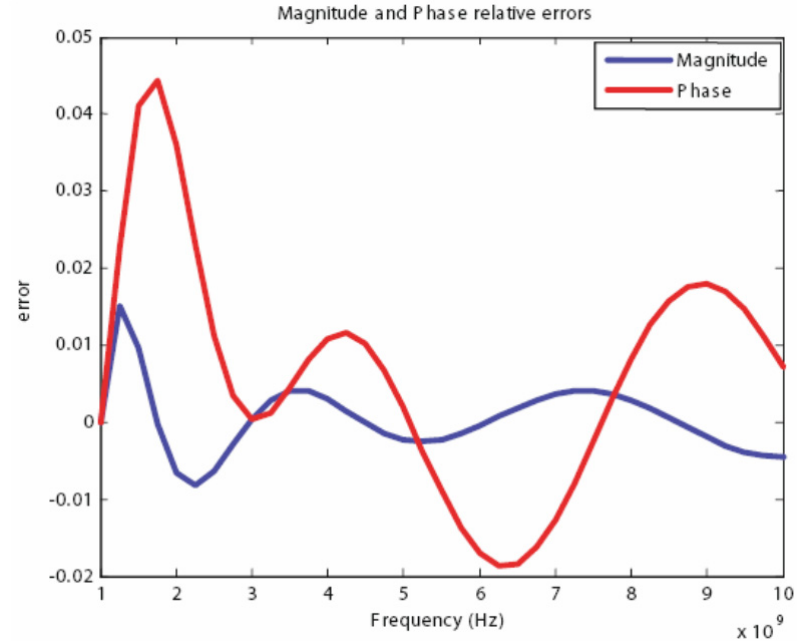
Figure 14. Magnitude and Phase relative errors of the spectrum approximation and the 4 Cole-Cole